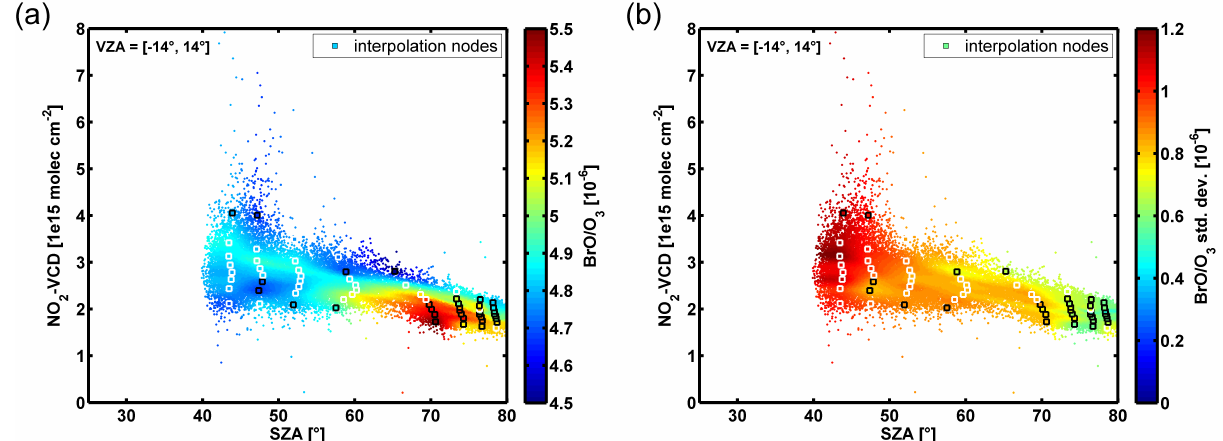
Fig. 5. Interpolation (a) of the BrO/O 3 SCD ratio surface and (b) its standard deviation σ depending on SZA and NO 2 VCD. The nodes of the bilinear surface interpolation (squares) are the mean of the partitions displayed in Fig. 3. The distributions of some partition with 1 a negligible asymmetry are not filtered before the interpolation and indicated by white